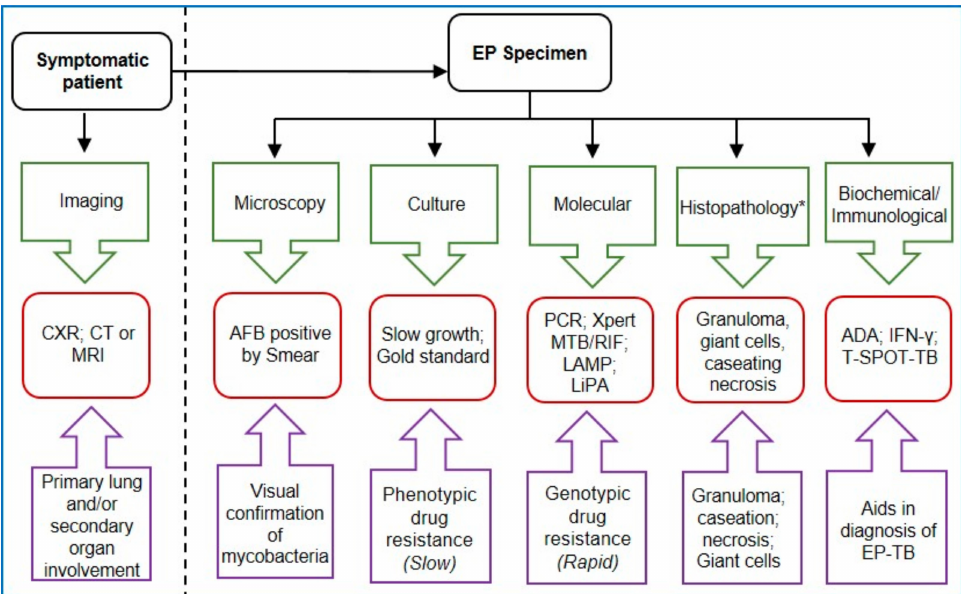
Figure 1. Flowchart showing panel of diagnostic tests for EPTB due to M. tuberculosis complex organisms. * Histopathology is performed based on the availability of samples and facility in the diagnostic lab. Abbreviations: EP, extrapulmonary; CXR, chest X-ray; CT, computed tomography; MRI, magnetic resonance imaging; AFB, acid-fast bacilli; PCR, polymerase chain reaction; LAMP, loop-mediated isothermal amplification; LiPA, line probe assay; ADA, adenosine deaminase; IFN- γ ,